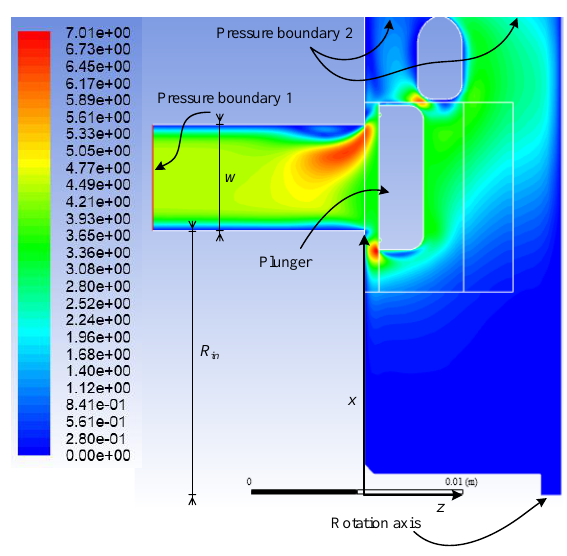
Figure 5: Velocity solution of the fluid flow problem from CFD (ANSYS Fluent 18) R = R in + 0 . 5 w = 15 mm, w = 5 mm and z goes from l s → 0.